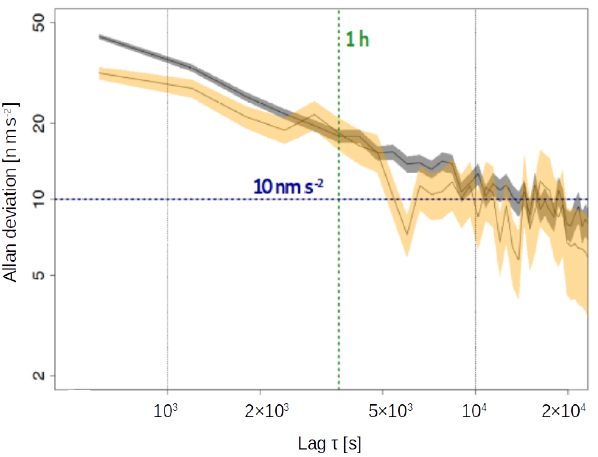
Figure 3. Allan deviation in nms − 2 for the first week of Decem- ber 2019 at the Larzac site. One-minute series were used for the iGrav-002 (grey), and 10min data for the AQB-01 (red). The ir- regular sampling frequency of the FG5-228 (100 drops every 10s, then 2600s break) was taken into account by plotting the short- term Allan deviation ( < 1000s for 10s data) and the long-term (1h data) one separately (both blue). The horizontal blue dashed line shows the sensitivity benchmark of 10nms − 2 , the dark green ver- tical dashed line signifies the integration period of 1h, and the light green one that of 24h.